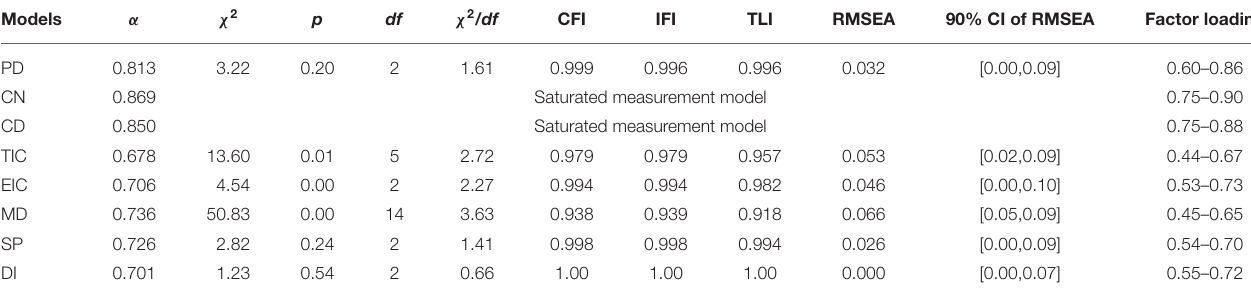
TABLE 1 | Fit indices of the measurement models ( N = 603).